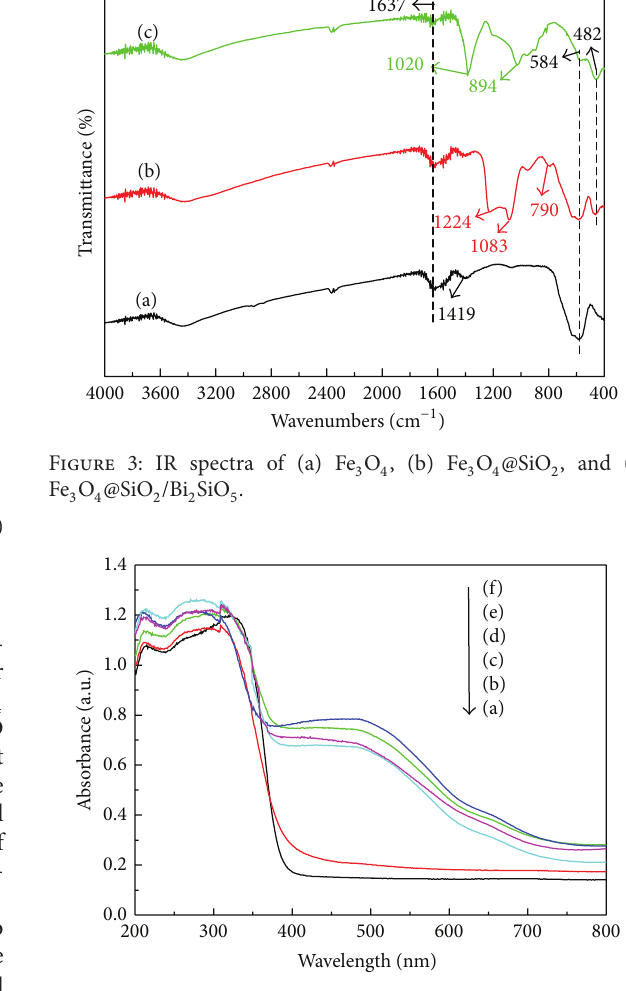
Figure 4: UV-vis absorption spectra of samples ((a) P25, (b) BSO-0, (c) BSO-0.05, (d) BSO-0.1, (e) BSO-0.2, and (f)